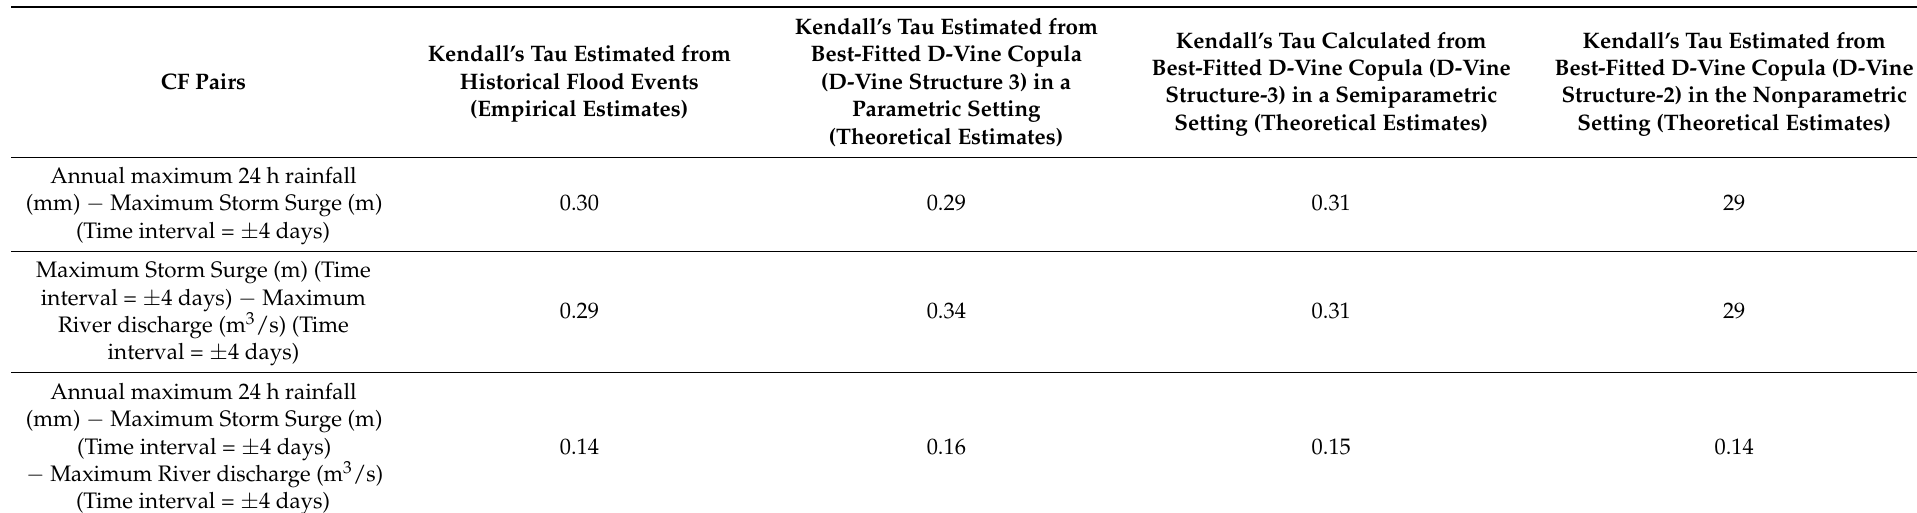
Table 8. Examining the reliability of the developed D-vine structure (nonparametric settings) vs. parametric D-vine vs. semiparametric D-vine copula framework by comparing Kendall’s τ correlation coefficient estimated using the generated random samples (size N = 1000) obtained from the above-selected model with Empirical Kendall’s τ values estimated from historical